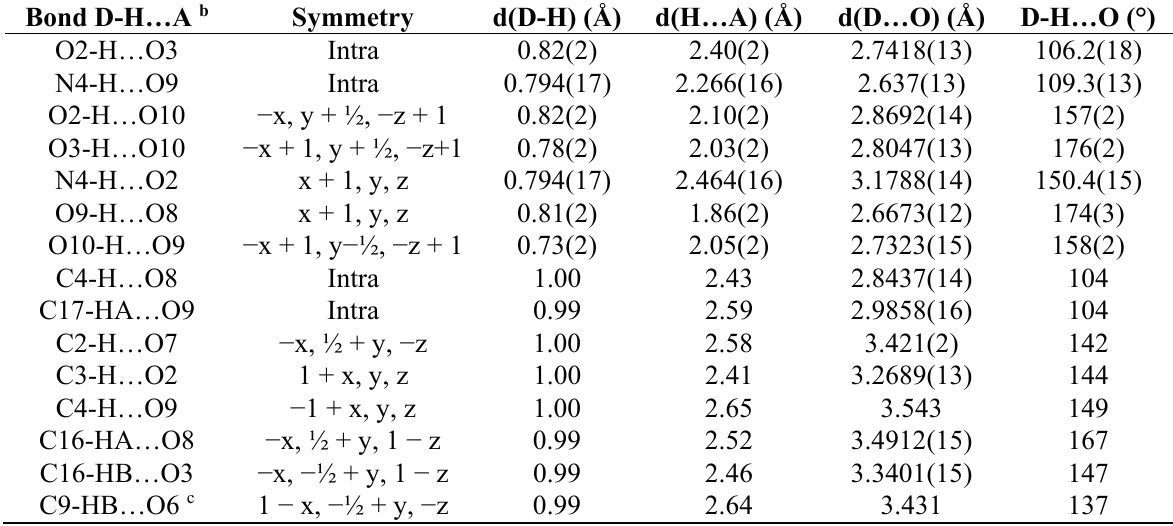
Table 2. Hydrogen bonds determined by PLATON criteria (hydrogen positions as determined) a .